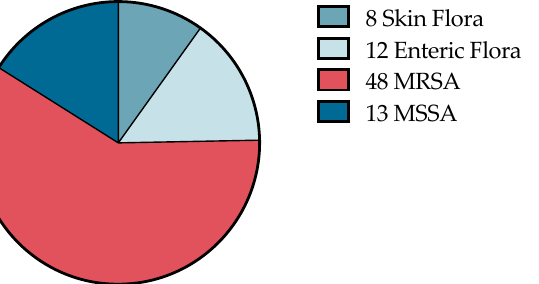
Figure 2. Bacteria identified in abscess wound cultures taken from abscesses. The most common bacteria identified was methicillin-resistant Staphylococcus aureus (MRSA) followed by methicillin- sensitive Staphylococcus aureus. The remainder showed skin and enteric flora.